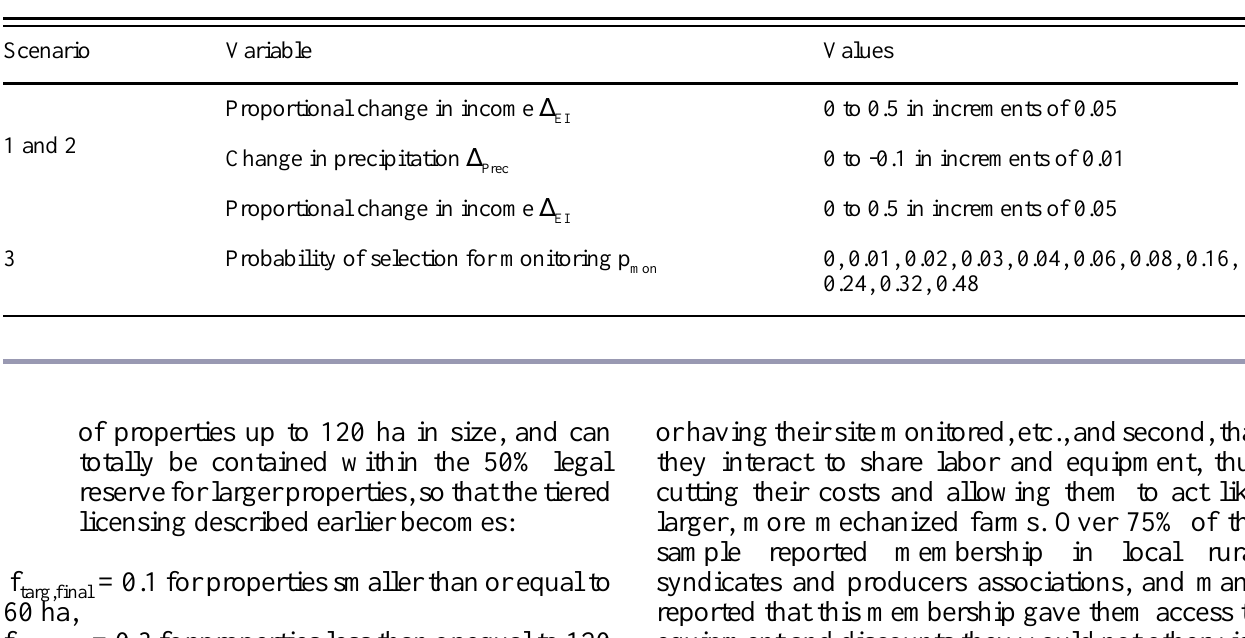
Table 1. Values for independent variables D EI and D Prec in response surfaces for policy scenarios 1 and 2, and for independent variables D EI and p in response surfaces for policy scenario mon